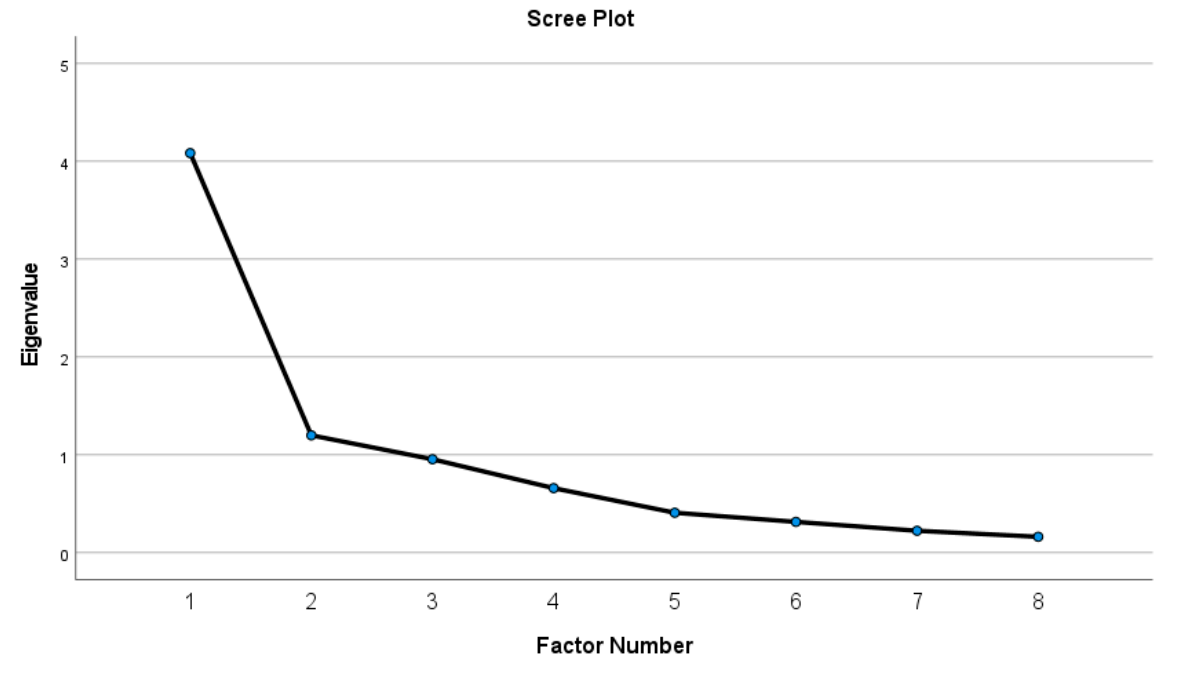
Figure 2. Scree Plot for Exploratory Factor Analysis. Table 10. Factor loadings and importance items of soil and nutrient management competencies.